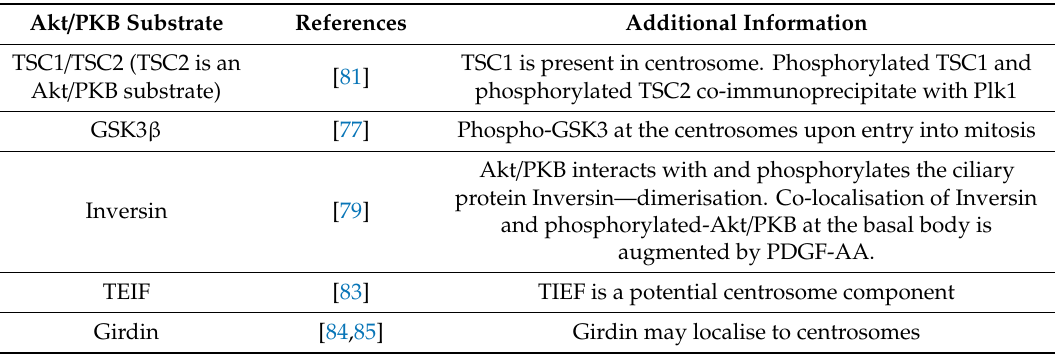
Table 2. Akt / PKB substrates found in centrosome / primary